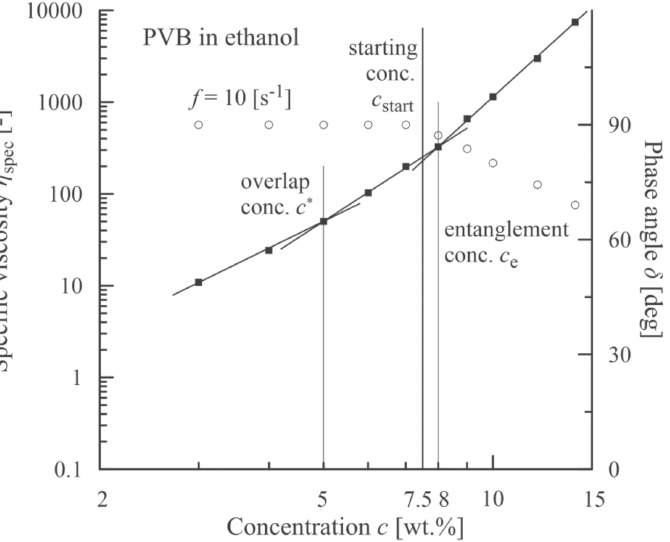
Figure 4. Correlation between an onset of viscoelasticity (a decrease in phase angle, open circles) and a starting concentration corresponding to an onset of beadless PVB